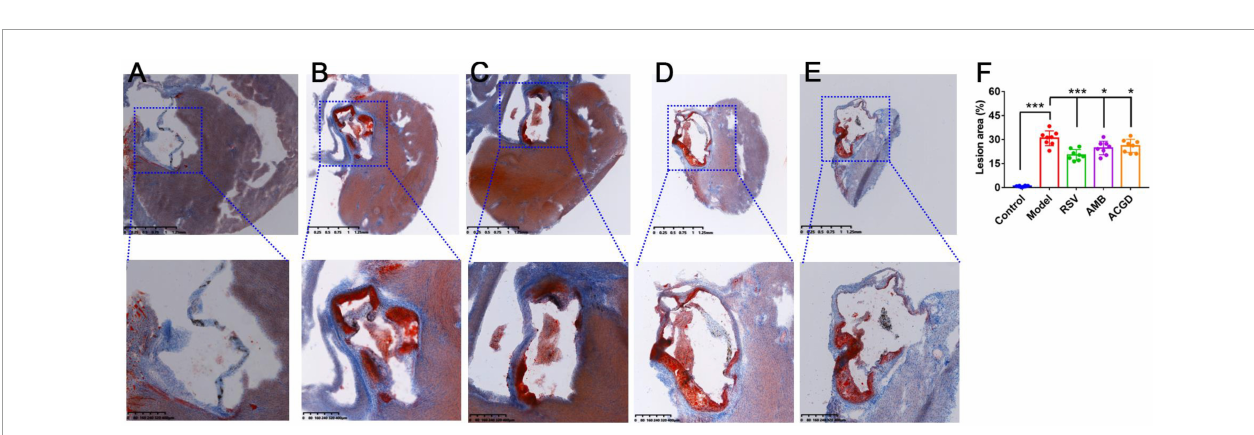
FIGURE5 The Oil red O staining results of aortic valves in mice from control group (A) , model group (B) , rosuvastatin calcium tablets (RSV) group (C) , Allium macrostemon Bge. (AMB) group (D), and Allium chinense G. Don (ACGD) group (E) . And the comparison of atherosclerotic plaque (F) . Data were presented as mean ± SD ( n = 8). (* p < 0.05, *** p <